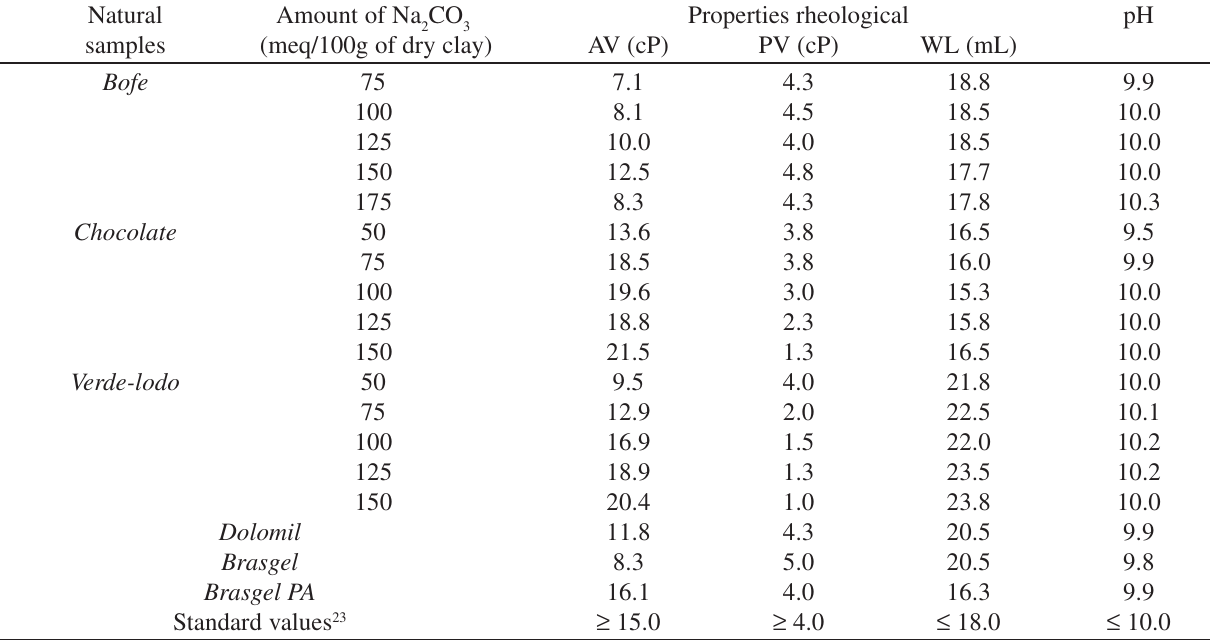
Table 4. Rheological properties of the suspensions prepared with the natural clays activated with Na with the industrialized